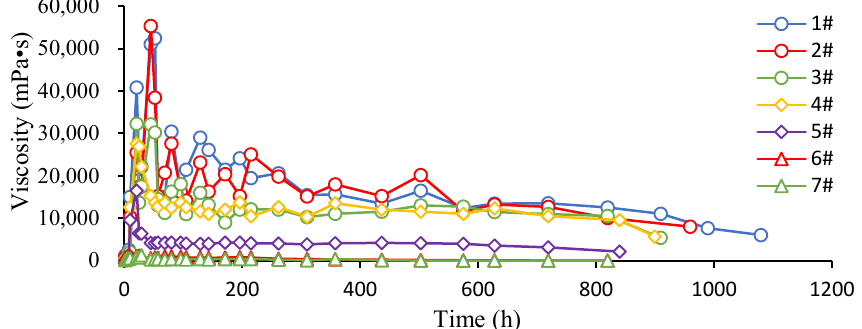
Figure 1. Viscosity versus time curve.